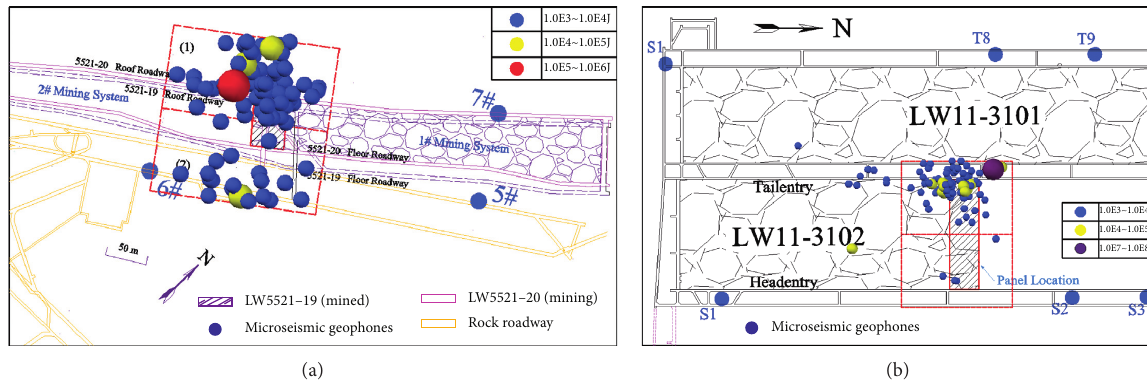
Figure 5: Location results of MS events ( > 10 3 J) before coal burst behaviors. (a) Location results of MS events in the LW5521-20 panel from June 4 to July 14, 2016. (b) Location results of MS events in LW11-3102 panel from February 1 to March 5,